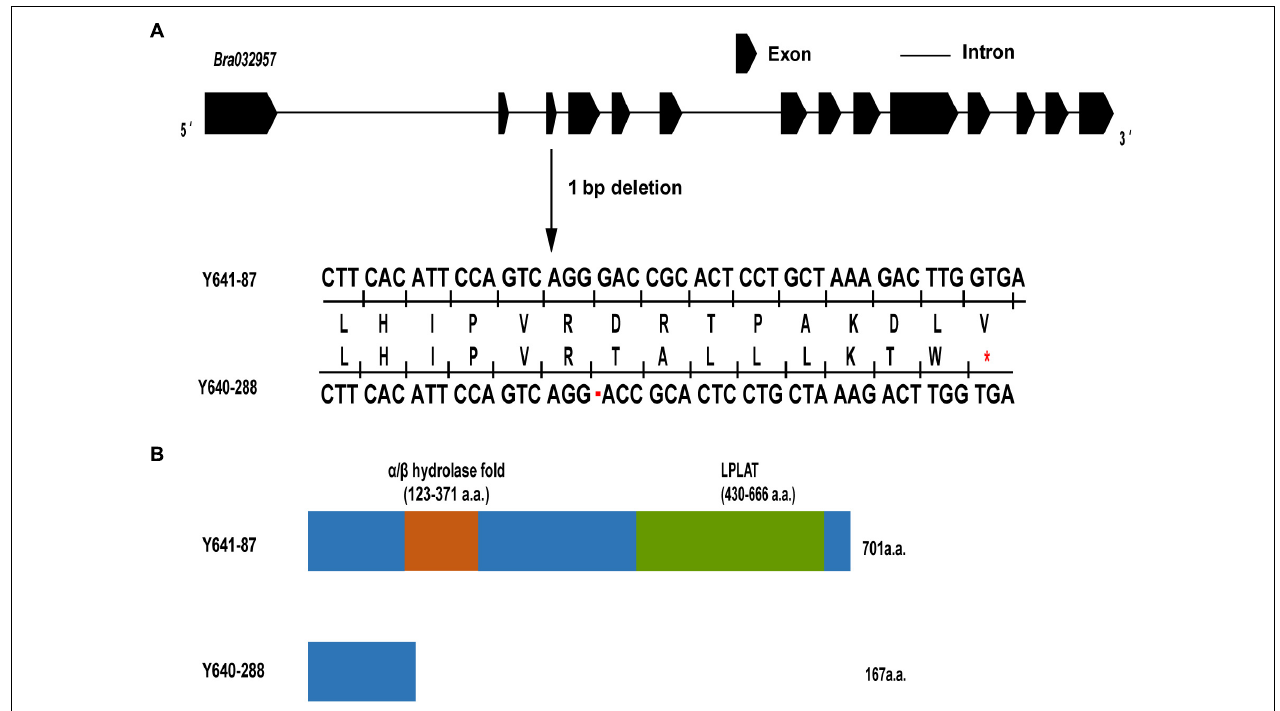
FIGURE 5 | Gene structure, amino acid analysis and predicted protein structure of BrWF3 . (A) BrWF3 includes 14 exons and 13 introns. A single nucleotide deletion (G) in the third exon of white flower plants results in a premature stop codon (indicated with red asterisks) due to a frameshift mutation. (B) Protein structures of BrWF3 in the two parents. The SNP deletion in Y640-288 causes the loss of two conserved protein domains of BrWF3.